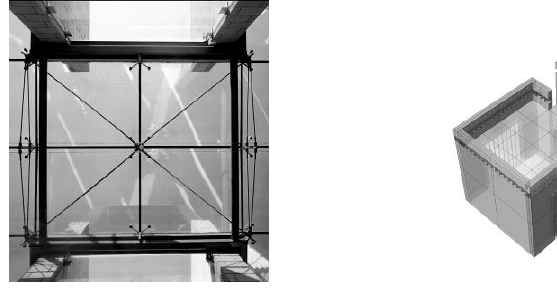
Figure 9 and 10: Flower shop in